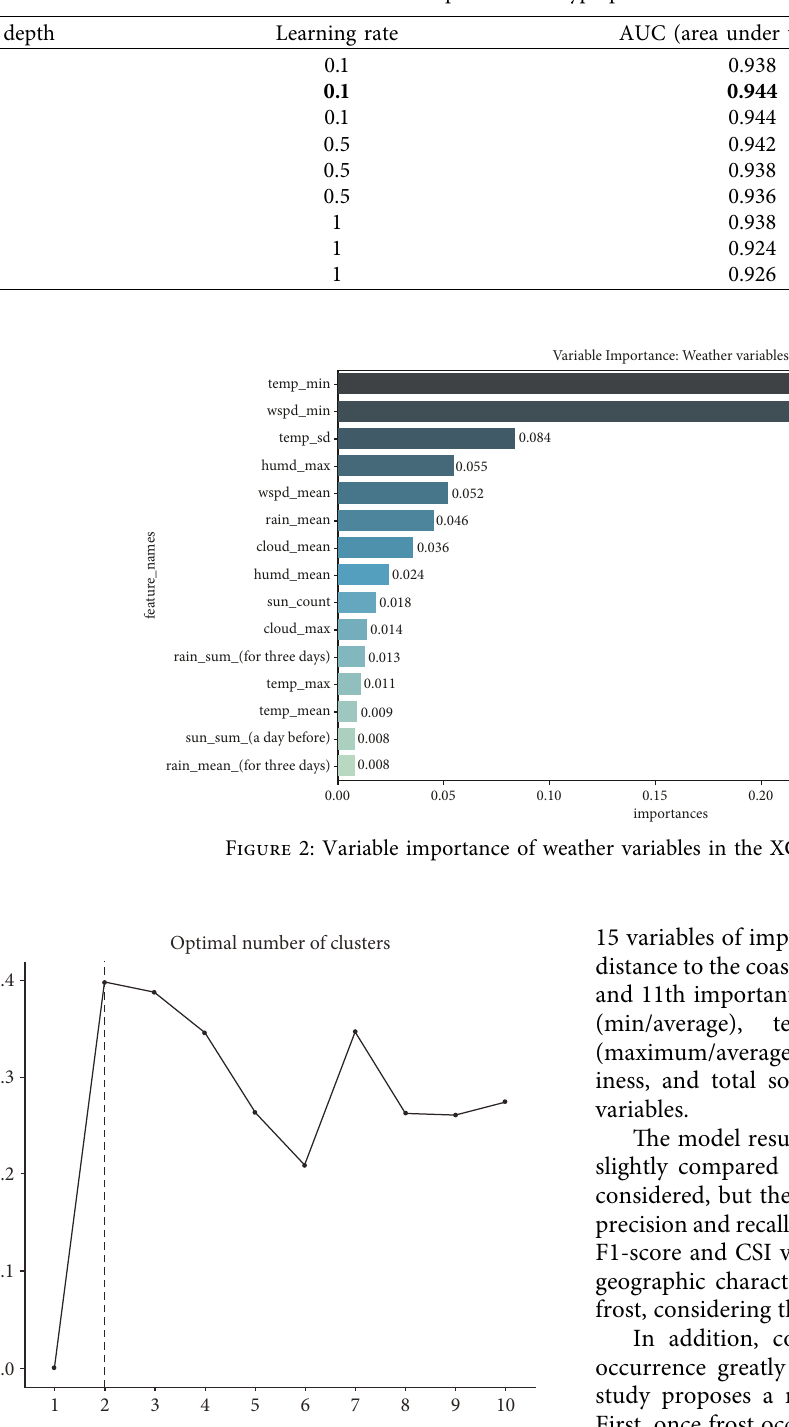
Table 5: Optimization hyperparameter